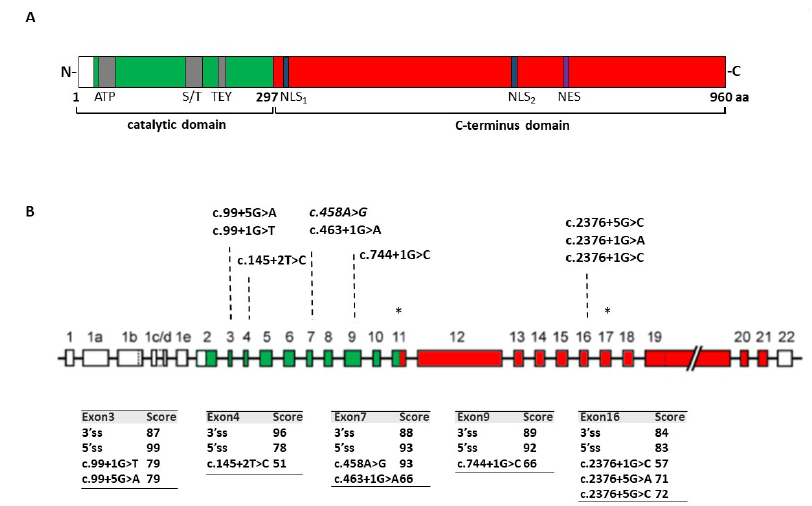
Figure 1. Schematic representation of the CDKL5 gene and protein. ( A ) Schematic representation of the human isoform hCDKL5-1 [18] with its principal functional domains. The catalytic domain is shown in green while the included ATP binding site (ATP), the Ser / Thr kinase active site (S / T) and the Thr-Glu-Tyr (TEY) motif are highlighted in grey. The C-terminus domain is depicted in red and the nuclear localization signals (NLS 1 and NLS 2 ) and nuclear export signal (NES) are in blue and violet, respectively. ( B ) Schematic representation of the CDKL5 gene with introns and exons represented respectively by lines and boxes. Nucleotide variants investigated in this study are reported in the upper part of the figure. Asterisks denote the exons whose presence di ff ers between di ff erent transcript isoforms. The bioinformatics prediction of 3 (cid:48) and 5 (cid:48) ss scores for each exon in normal and pathological condition is reported in the lower part of the